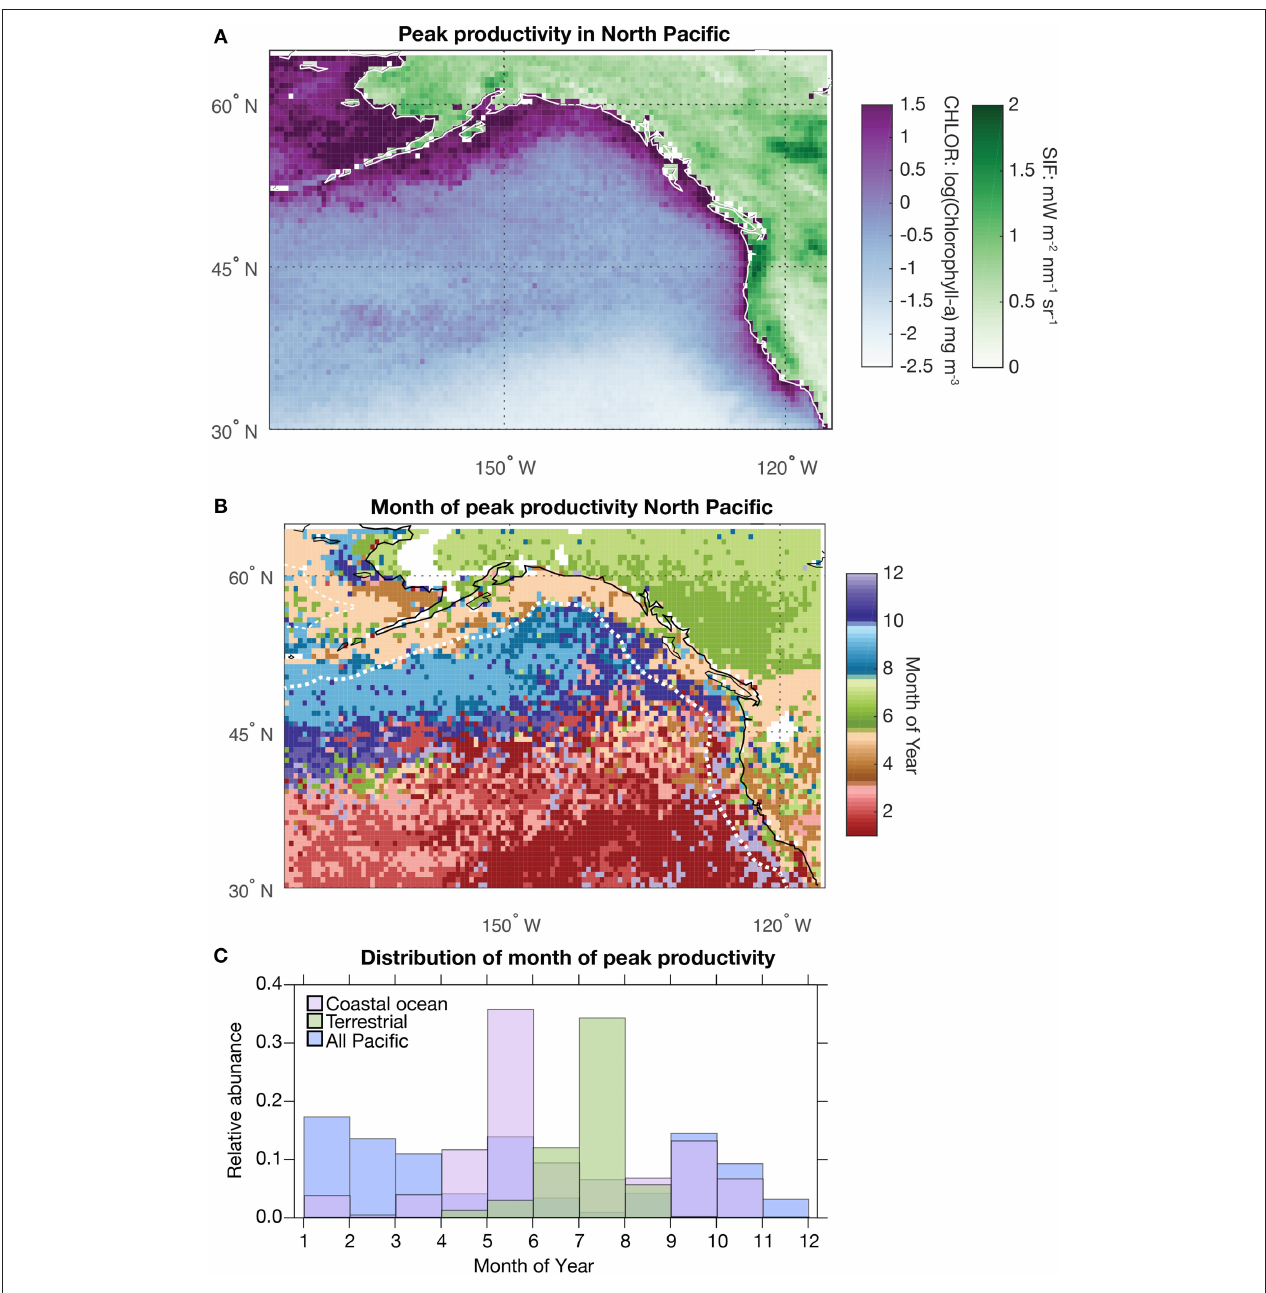
FIGURE 2 | (A) Map showing the average of each year’s maximum value for Solar-Induced Fluorescence (SIF) (greens) and chlorophyll- α (purples). (B) Map showing the average month that each grid cell reaches its peak in SIF and chlorophyll- α (as in A ). The SIF data spans 2007–2017 and the chlorophyll- α data spans 2003–2017. Each dataset was gridded to a common 0.5 ◦ spatial resolution ( Figure 1 ). (C) Distribution of the month of peak SIF and chlorophyll based on the data in (B) . The coastal chlorophyll data includes all grid cells contained within the dotted white line shown in (B) (as in Figure 8 ).